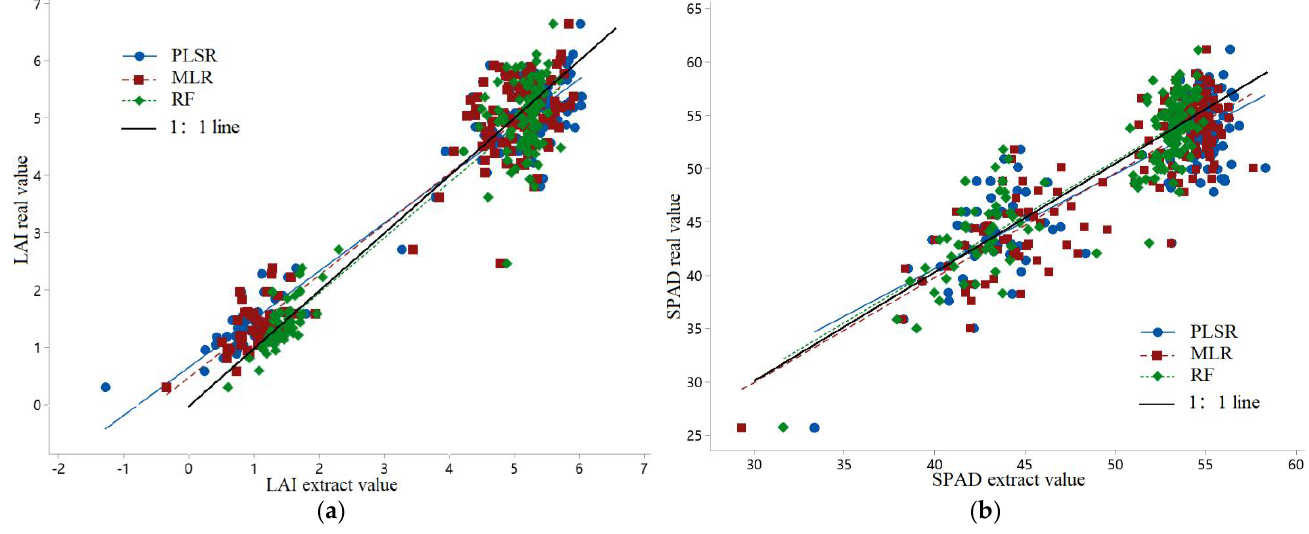
Figure 7. Scatter plot of extraction results and measured values of each model prescription map. ( a ) LAI model; ( b ) SPAD model.